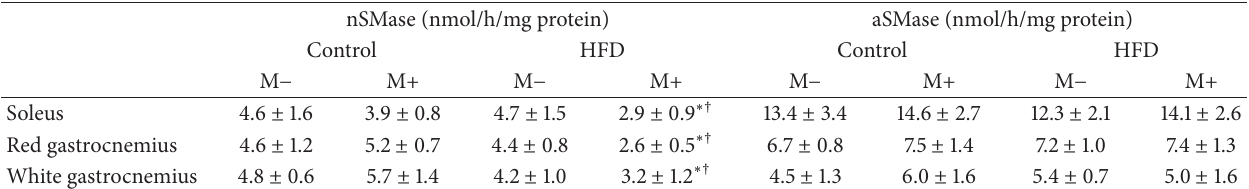
Table 2: Effect of myriocin treatment (for 7 days) and high fat diet feeding (for 5 weeks) on the neutral (nSMase) and acidic (aSMase) sphingomyelinases activities in rat skeletal muscle [ 𝑛 (per group) = 8].